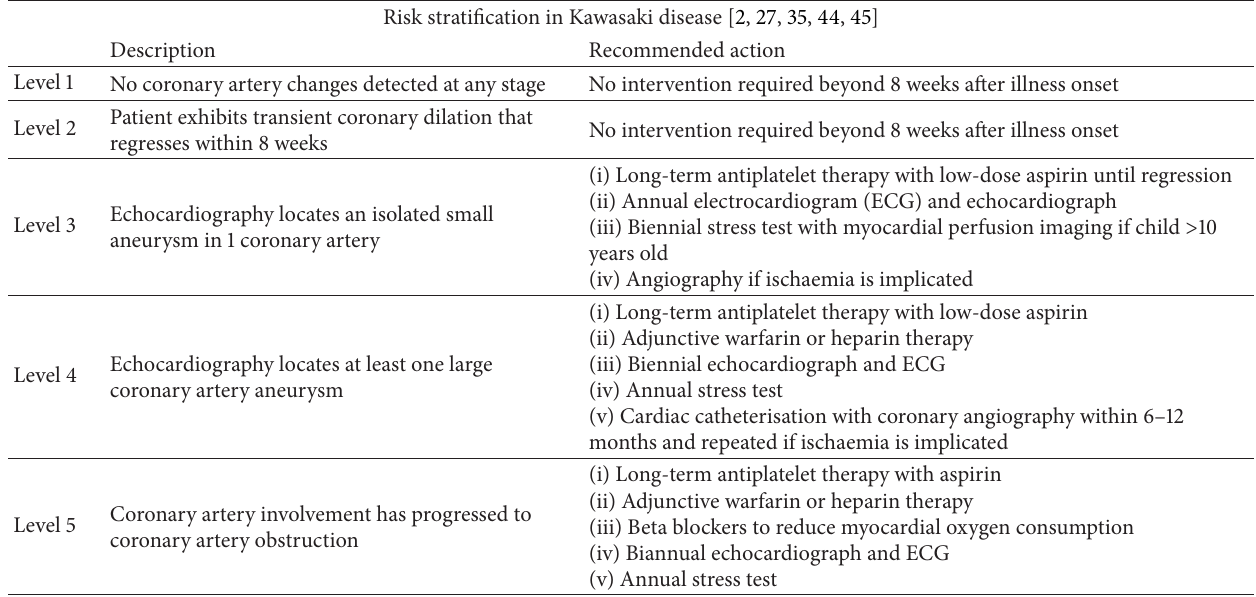
Table 2: Risk stratification based on degree of coronary artery